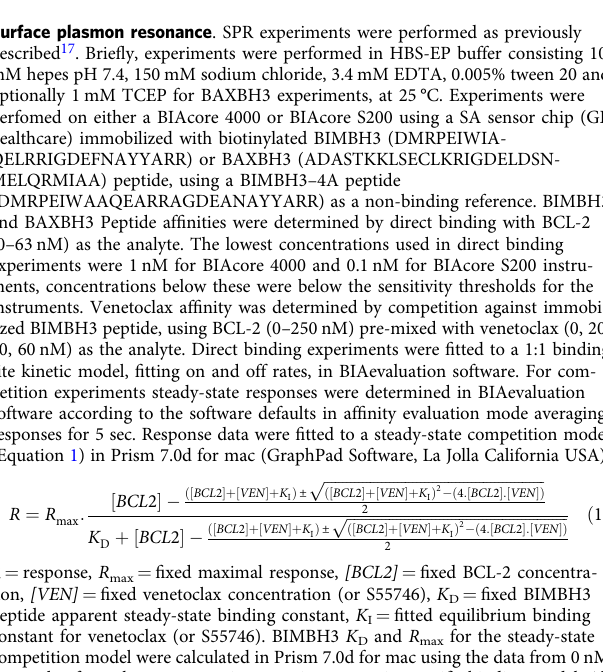
Supplementary Table 1. RMSD values were calculated for each structure relative to the BCL-2 WT:venetoclax cyclohex-1-ene ring A conformer. Surface plasmon resonance . SPR experiments were performed as previously described 17 . Brie fl y, experiments were performed in HBS-EP buffer consisting